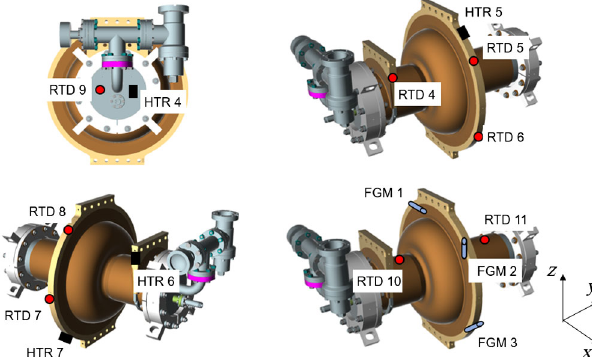
FIG. 20. Approximate locations of heaters (black rectangles), temperature sensors (red circles) and FGMs (blue cylinders) installed on the prototype cavity inside the HTC.